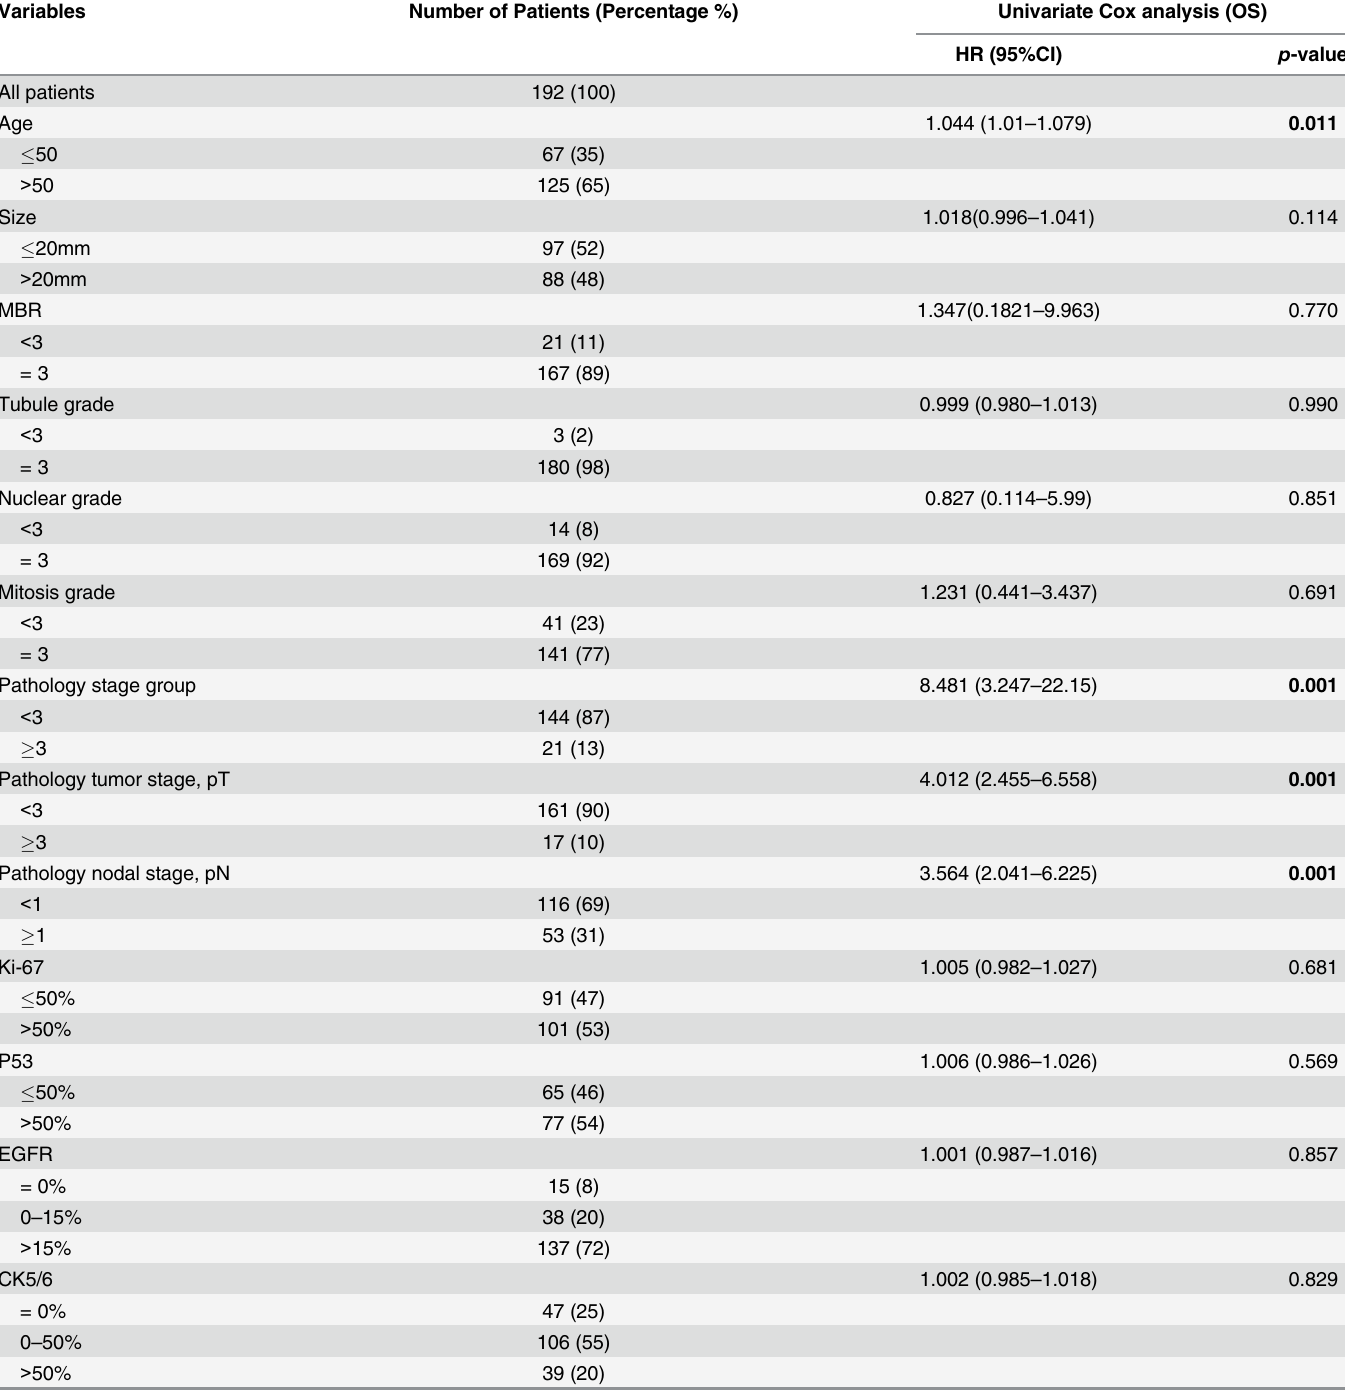
Table 1. Patients